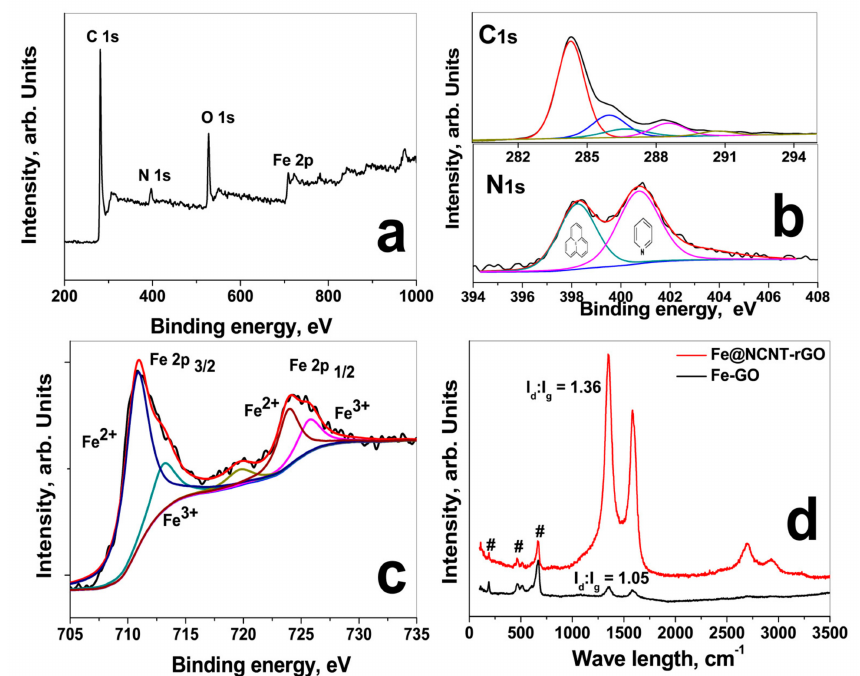
Figure 2. XPS survey scan ( a ); Deconvoluted C 1s spectra of GO (upper part) and Fe@NCNT-rGO (lower part) in ( b ); deconvoluted Fe 2p spectra ( c ) and Raman spectra ( d